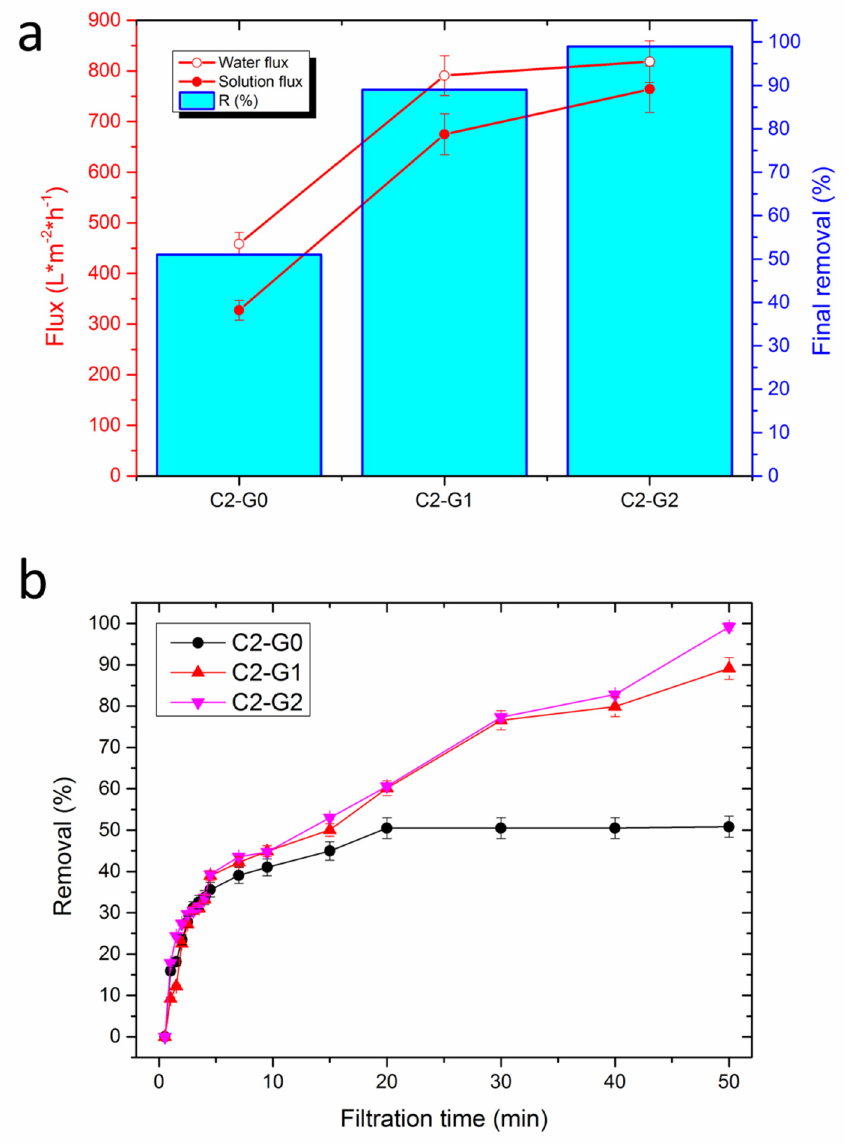
Figure 7. ( a ) Water and solution flux, along with the final removal of MB, as a function of the GO content of hybrid membranes; ( b ) removal as a function of filtration time, for the three systems investigated.